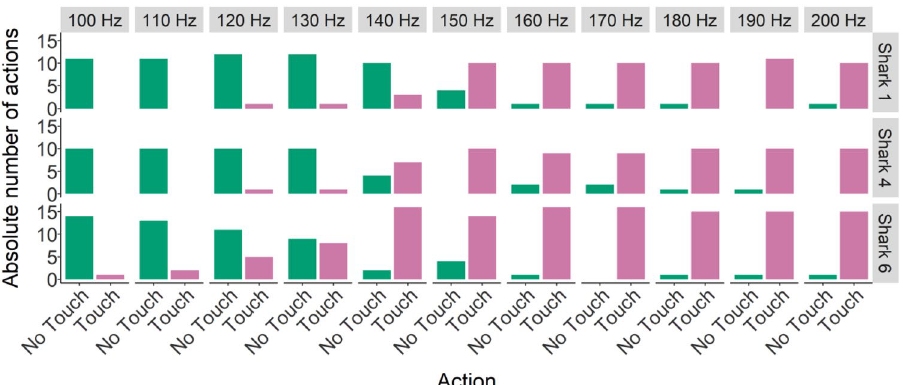
Figure 10. Grouped supersession data absolute number of action (not touching or touching the loudspeaker) per unfamiliar frequency (100–200